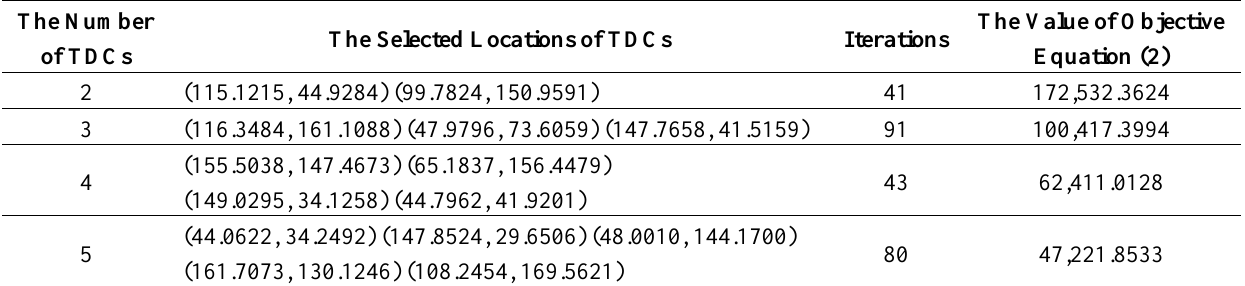
Table 2. Results with different numbers of the selected